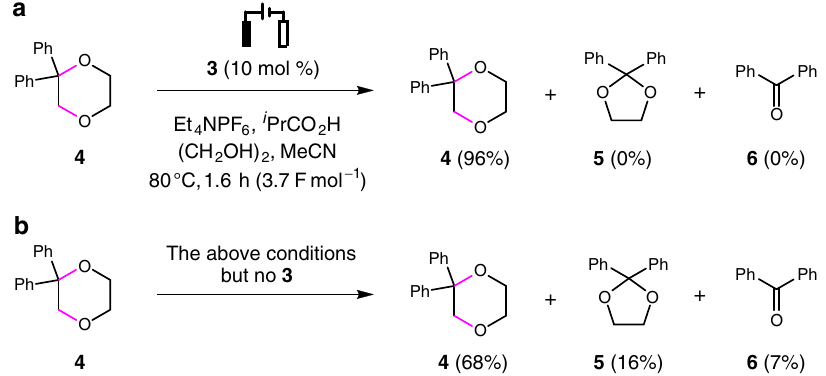
Fig. 4 Electrolysis of compound 4 . a Electrolysis of 4 in the presence of triarylamine 3 . b electrolysis of 4 in the absence of 3 . Yields were determined by 1 H NMR using 1,3,5-trimethoxygenzene as the internal standard NATURE COMMUNICATIONS| (2018) 9:3551 |DOI: